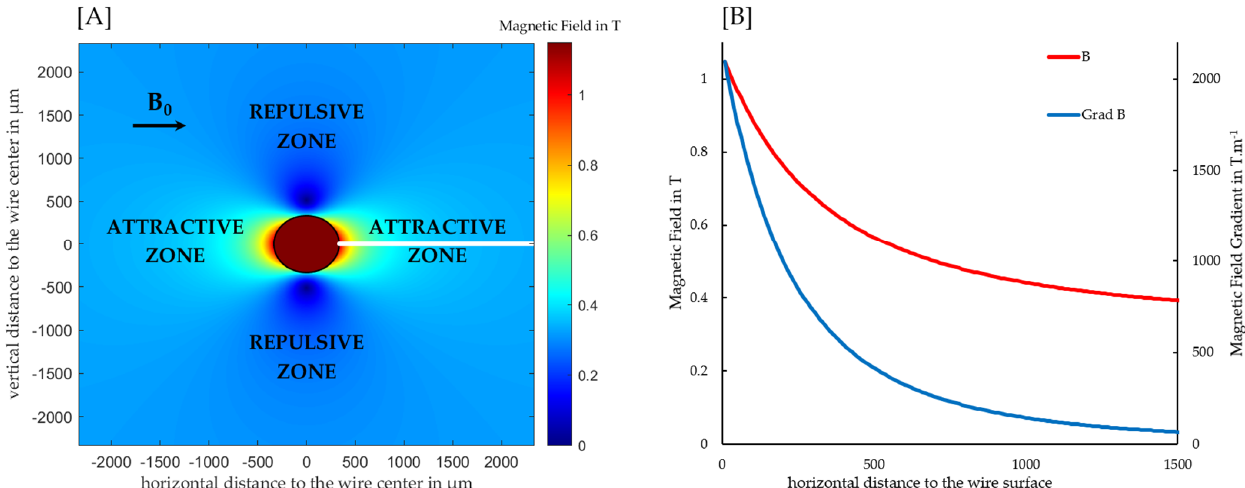
Figure 1. ( A ) Distribution of the magnetic field around a 430 grade stainless steel wire with a diameter of 670 µ m in a horizontal background field with an intensity of 0.32 T, simulated according to Equation (1), based on hysteresis loops reported by Franzreb, the saturation polarization was estimated at 1.5 T [27]. Due to the direction of the magnetic field gradient, the wire surface is attractive and repulsive to paramagnetic particles in the longitudinal and transversal direction, respectively. ( B ) Course of the magnetic field and its gradient on a line perpendicular to the wire surface and longitudinal to the background field with increasing distance to the wire surface.